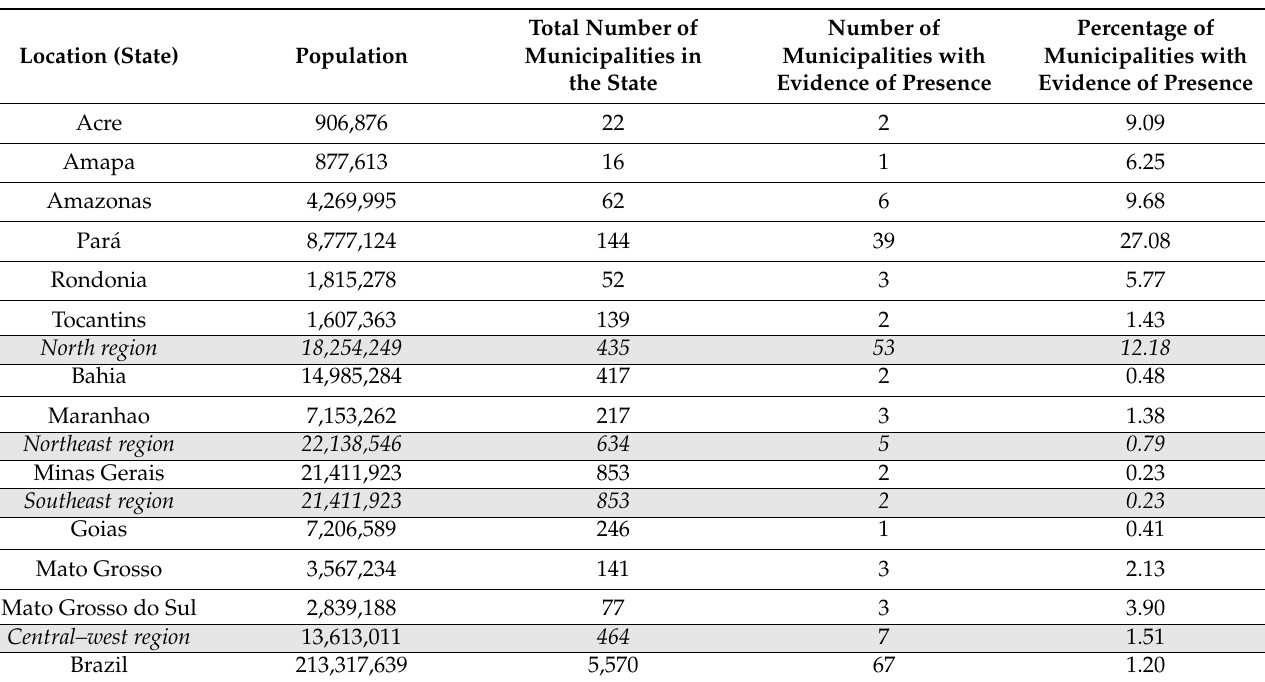
Table 3. Evidence of the presence of Oropouche virus organized by second subnational level within the states of Brazil